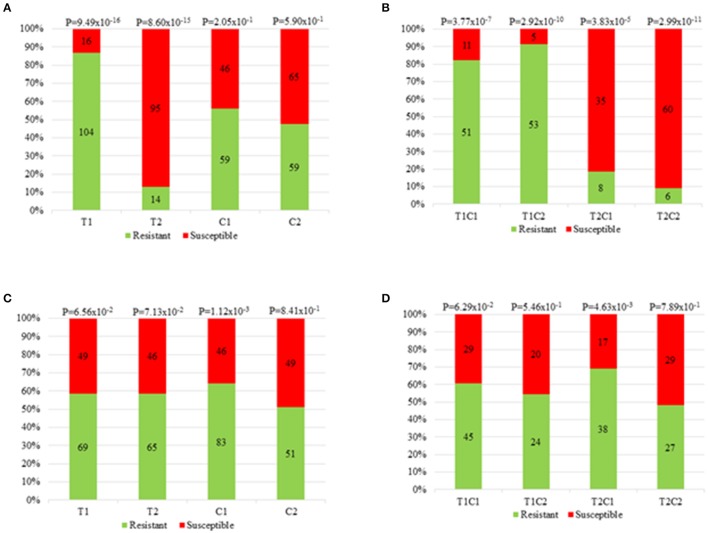
Frequency of resistant and susceptible trees. The frequency of resistant and susceptible trees are given for (A,C) each parental haplotype and (B,D) are given for each parental haplotype combination for the major QTL on chromosome VI (QTcNdp-chr6 and QTcXll-chr6) and minor QTL on chromosome IV (QTcXll-chr4), respectively. The different haplotypes and haplotype combinations are shown on the x-axis, while on the y-axis are shown the percentages of resistant (light green bar) and susceptible trees (light red bar). The p-values from the chi-square test for each different haplotype and haplotype combination are shown on the top of stacked bars.